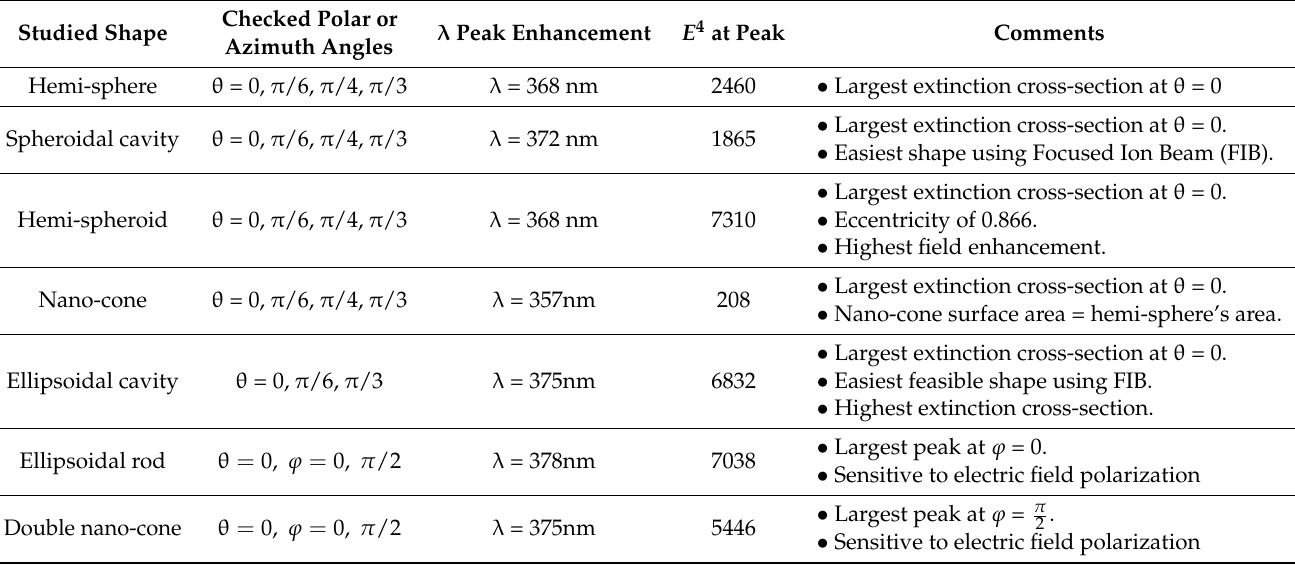
Figure 13. Extinction cross-section: comparison between different nano-particle geometries. Table 3. Comparison table of the studied particle’s shapes based on E 4 approximation.